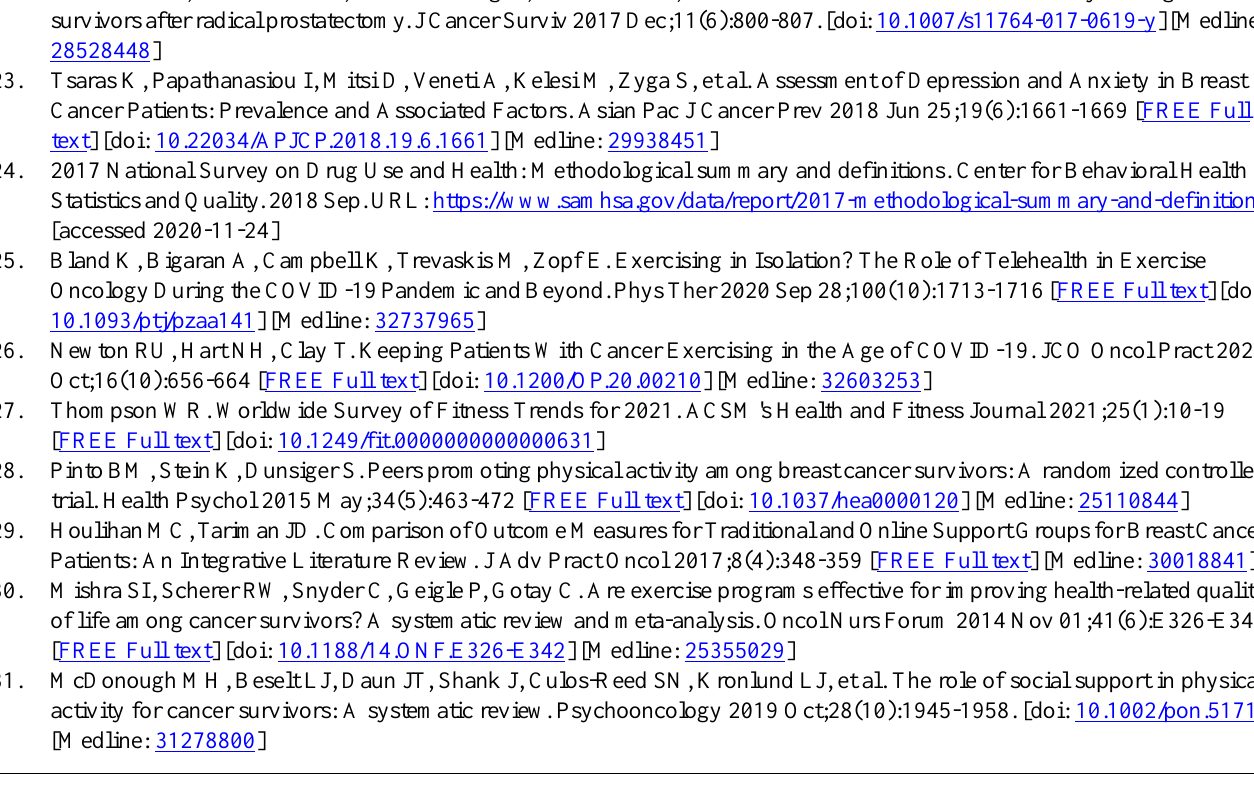
GAD-2: 2-item Generalized Anxiety Disorder PHQ-2: Patient Health